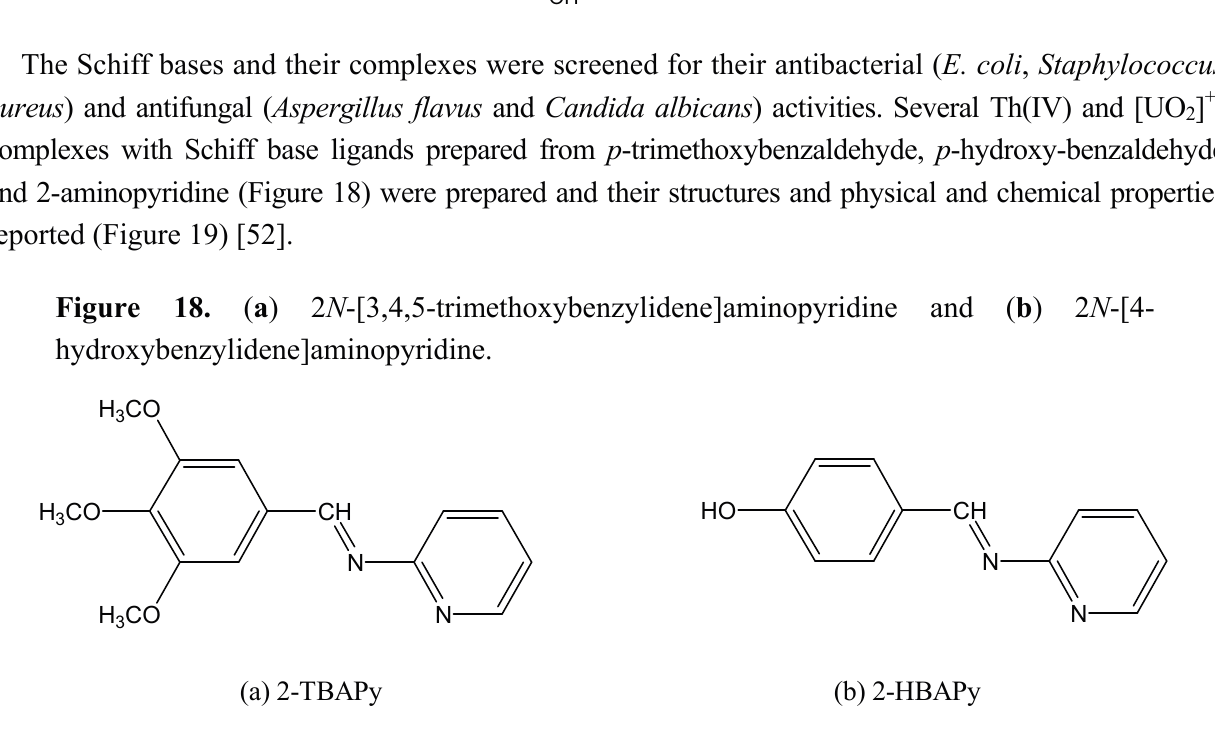
Figure 19. The proposed coordination numbers and structures for selected thorium complexes of 2-TBAPy and